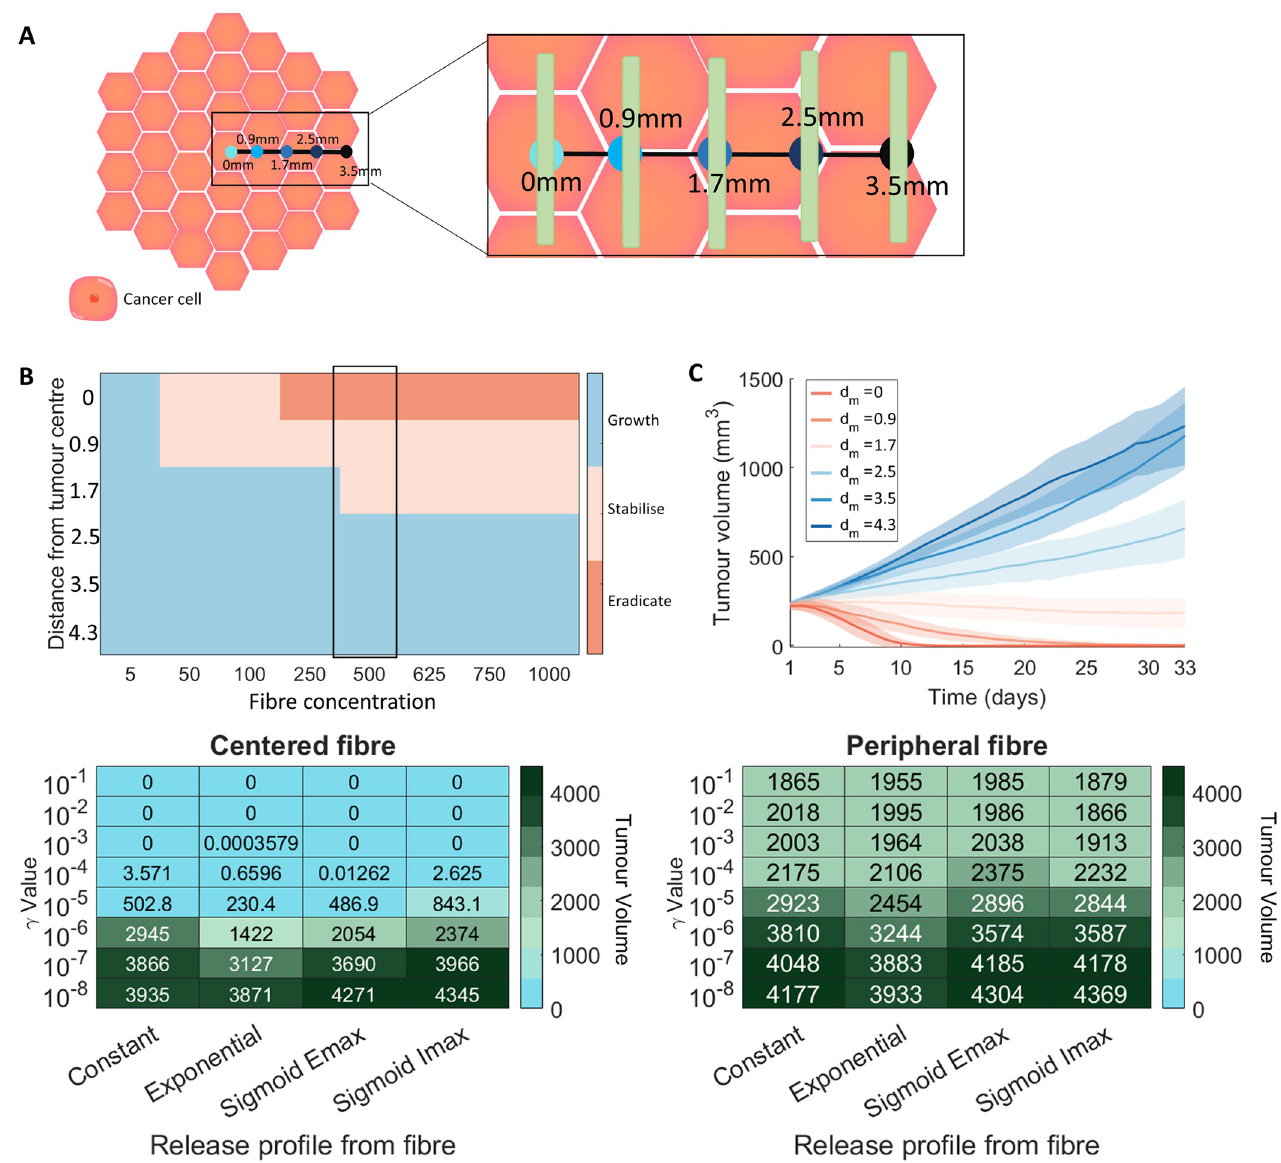
Fig 6. Comparison of different fibre release and placement options. (A) Tumour growth was investigated under different gemcitabine–loaded fibre placements d m : central, 0.9 mm from centre, 1.7 mm from centre, 2.5 mm from centre, 3.5 mm from centre and 4.3 mm from centre. Locations of fibres on tumour surface for single implantations is depicted schematically. (B) A heatmap for the averaged final state of a tumour after 33 days of simulation for different initial injection concentrations and fibre placements. “Eradicate” denotes a tumour volume below 1 mm 3 , “stabilise” denotes a tumour volume less than the initial tumour volume, and “growth” denotes a tumour volume greater than the initial tumour volume. (C) The mean (solid lines) and standard deviation (shades areas) of the tumour volume over 33 days for different fibre placement options with corresponding values highlighted in (B). (D) The tumour volume on day 33 for different release rates (indicated by the γ value) and release profiles with a central fibre placement. (E) The tumour volume on day 33 for different release rates (indicated by the γ value) and release profiles with a fibre placed on the edge of the tumour (3.5 mm away from centre). See Section TS3 in S1 Technical Supplementary Information for more details on these release functions. Legend for cell colouring: cancer cell